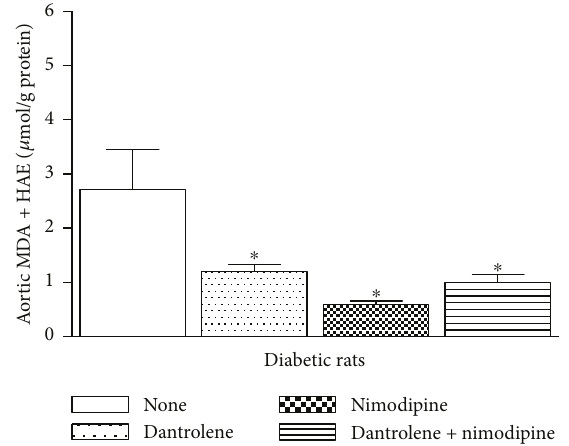
Figure 6: E ff ects of a 30min incubation period with dantrolene (50 μ M), with nimodipine (50 nM), and with both drugs in combination on MDA +4-HAE levels in aortic homogenates from STZ diabetic rats. Lipid peroxidation levels were signi fi cantly reduced by dantrolene, nimodipine, and both drugs in combination. The values shown are the means ± SEM of 5 animals per group. ∗ P < 0 05 , when comparing treated and untreated